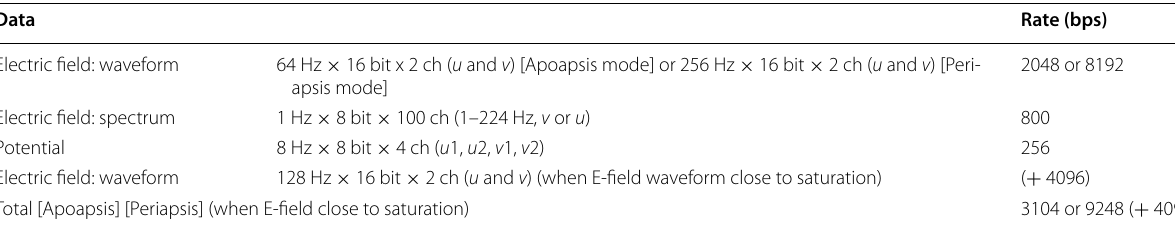
Table 3 Continuous-mode data from the EFD system Data Rate (bps) Electric field: waveform Electric field: spectrum Electric field: